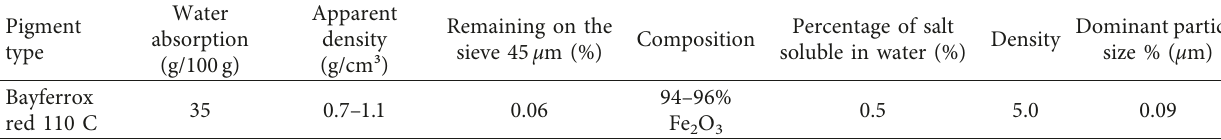
Table 2: Physical and chemical properties of pigment.